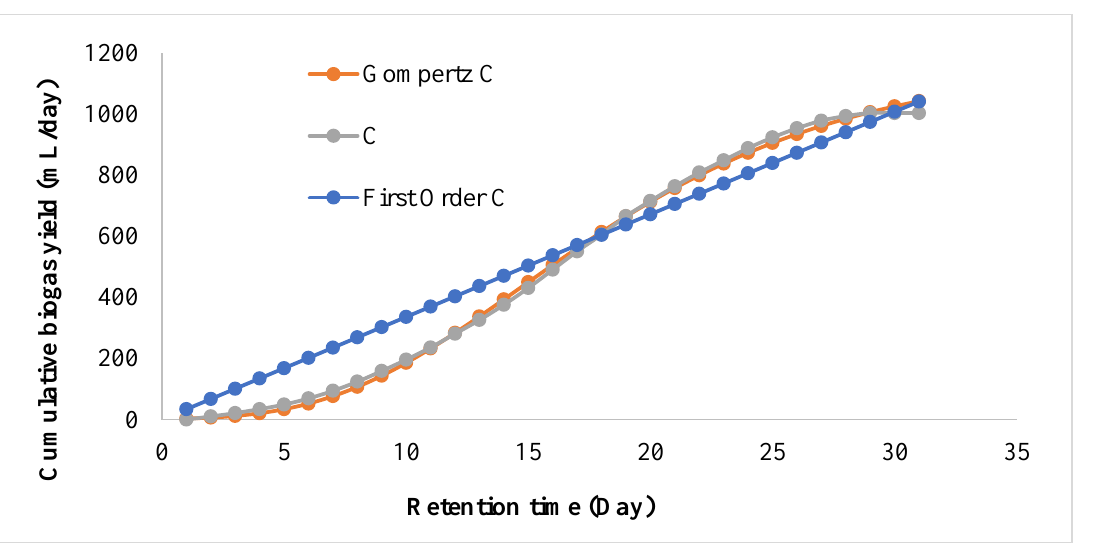
Figure 5. Fitting of cumulative biogas yield of bioreactor C (CmF) with highest R 2 (0.9986) on first-order and modified Gompertz kinetic models. Table 4. Summary of the kinetic study for bioreactors: A (mF), B (NmF), C (CmF), D (TmF), E (ChTmF), F (CTmF), G (ATmF), and H (no MNM) fitted on first-order and modified Gompertz mod- els.